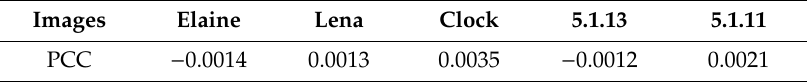
Table 3. Correlation Coe ffi cient value between plain and cipher images.